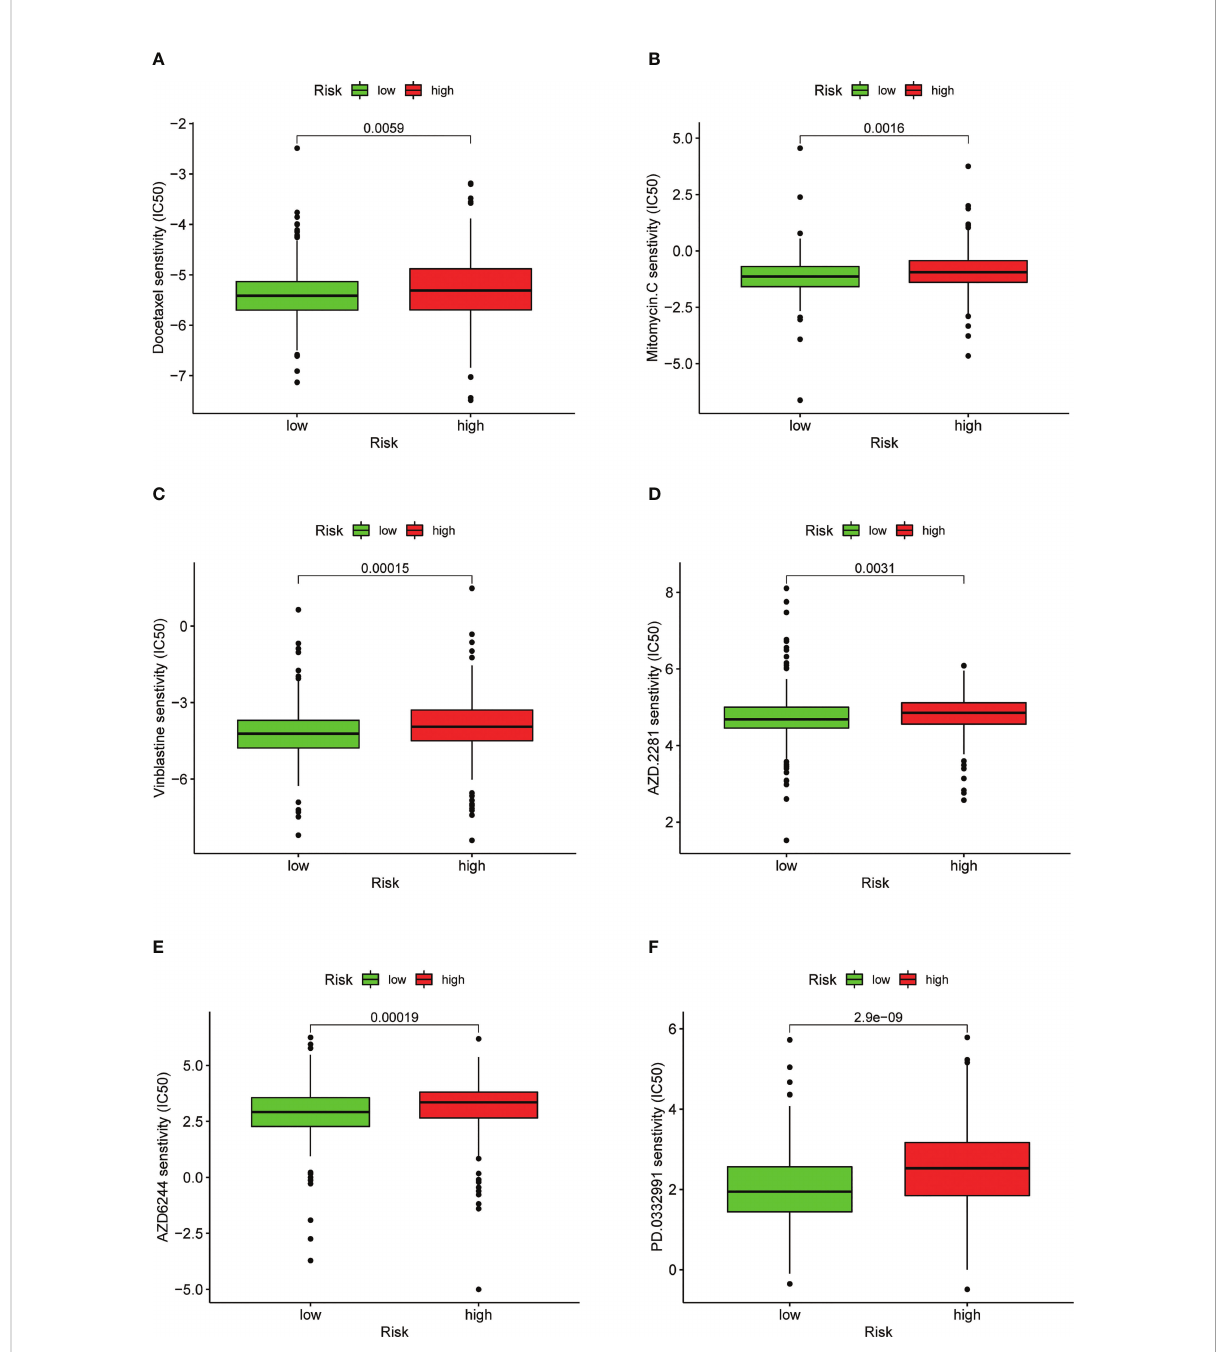
FIGURE 11 Drug sensitivity between low- and high-risk groups. (A) IC50 of docetaxel in low- and high-risk groups. (B) IC50 of mitomycin.C in low- and high-risk groups. (C) IC50 of vinblastine in low- and high-risk groups. (D) IC50 of AZD.2281 (olaparib) in low- and high-risk groups. (E) IC50 of AZD6244 in low- and high-risk groups. (F) IC50 of PD.0332991 (palbociclib) in low- and high-risk